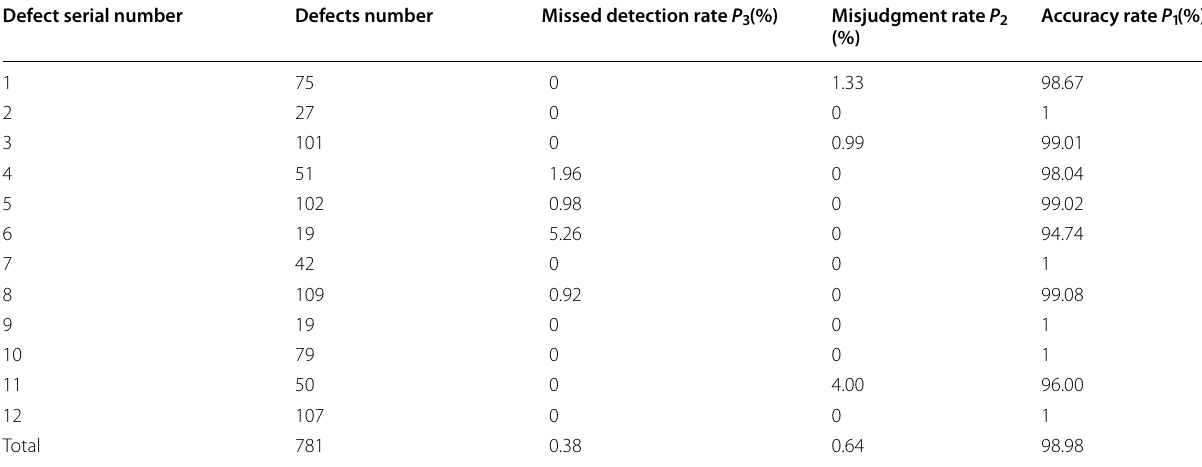
Table 2 Test results of ultrasonic image for railway track sample images Defect serial